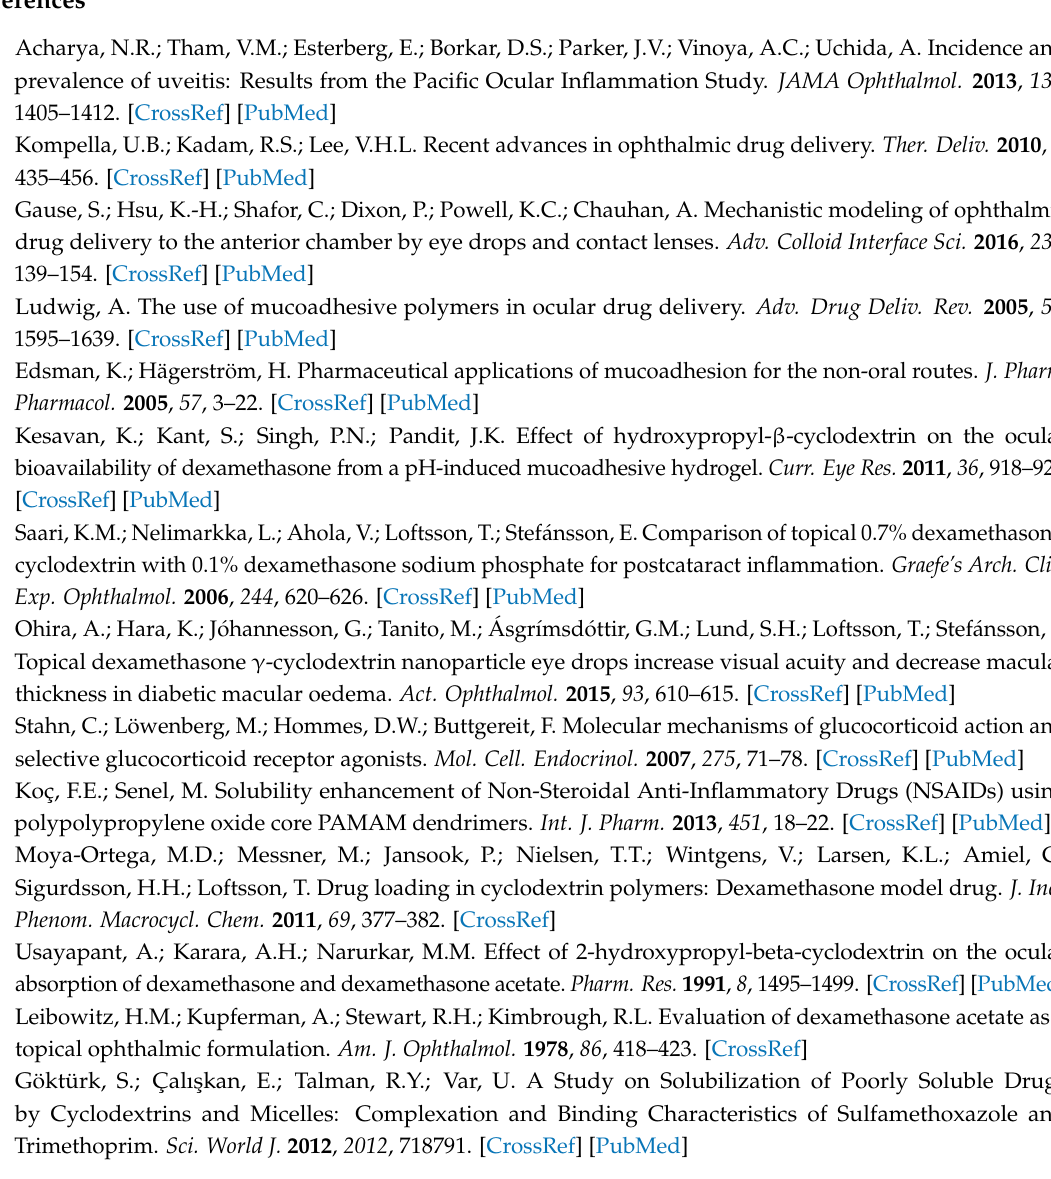
Table S1: Optimization of mixed gel based on HP β CD, Table S2: Optimization of mixed gel based on HP γ CD, Table S3: Analysis of variance for Reduced Special Cubic Mixture models (Partial sum of squares—Type